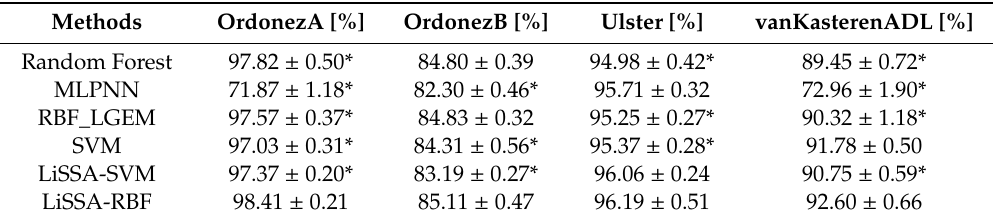
Table 5. F1_score of di ff erent methods on four datasets. Results are obtained from 10-fold cross validations conducted five